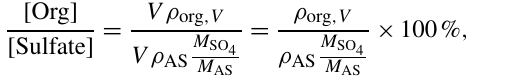
Figure 4. [Org] / [Sulfate] in AS aerosols versus particle mobility size ( d m ) during EXP P1 scanning the six nebulized AS concentra- tions (0.01–0.5M). The colored dots (with error bars) are the exper- imental data, while the red and black lines represent the calculated [Org] / [Sulfate] considering either surface coating of organic mat- ter (in red from Eq. 3) or internal mixing (in black from Eq. 4).